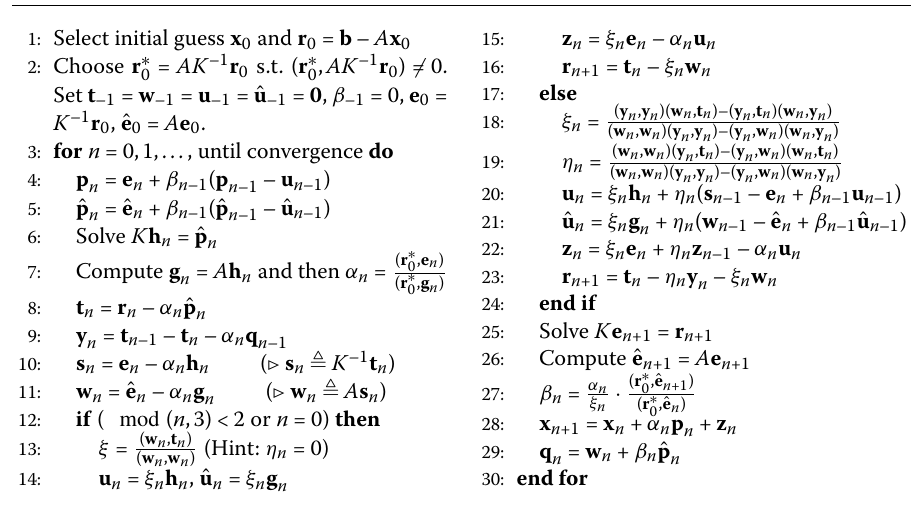
Algorithm 4.1 PGPBiCOR(2,1) for A x = b with preconditioner